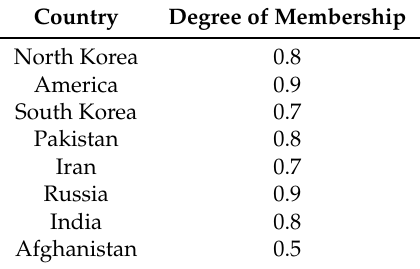
Table 1. Fuzzy set σ of countries.